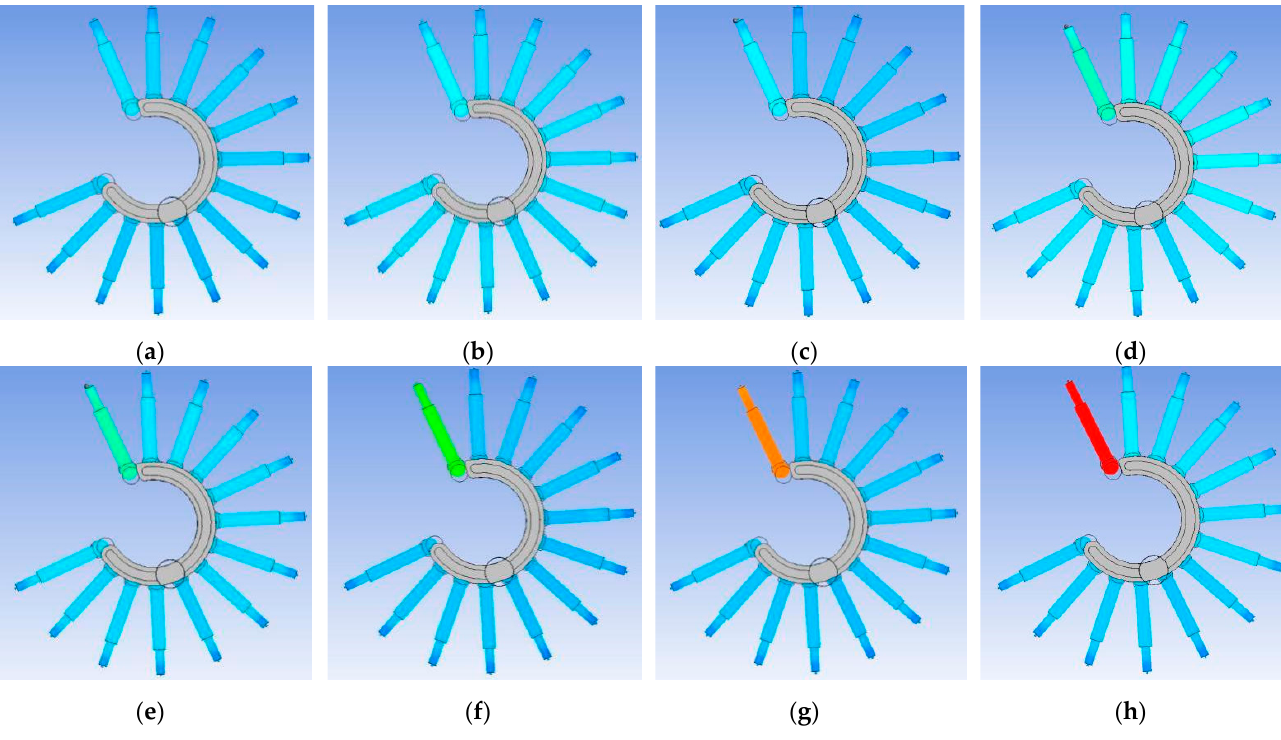
Figure 11. Negative pressure distribution chart of groups 41–48: ( a ) group 41; ( b ) group 42; ( c ) group 43; ( d ) group 44; ( e ) group 45; ( f ) group 46; ( g ) group 47; ( h ) group 48. On the whole, when only a small part of the air-passing aperture is connected to the